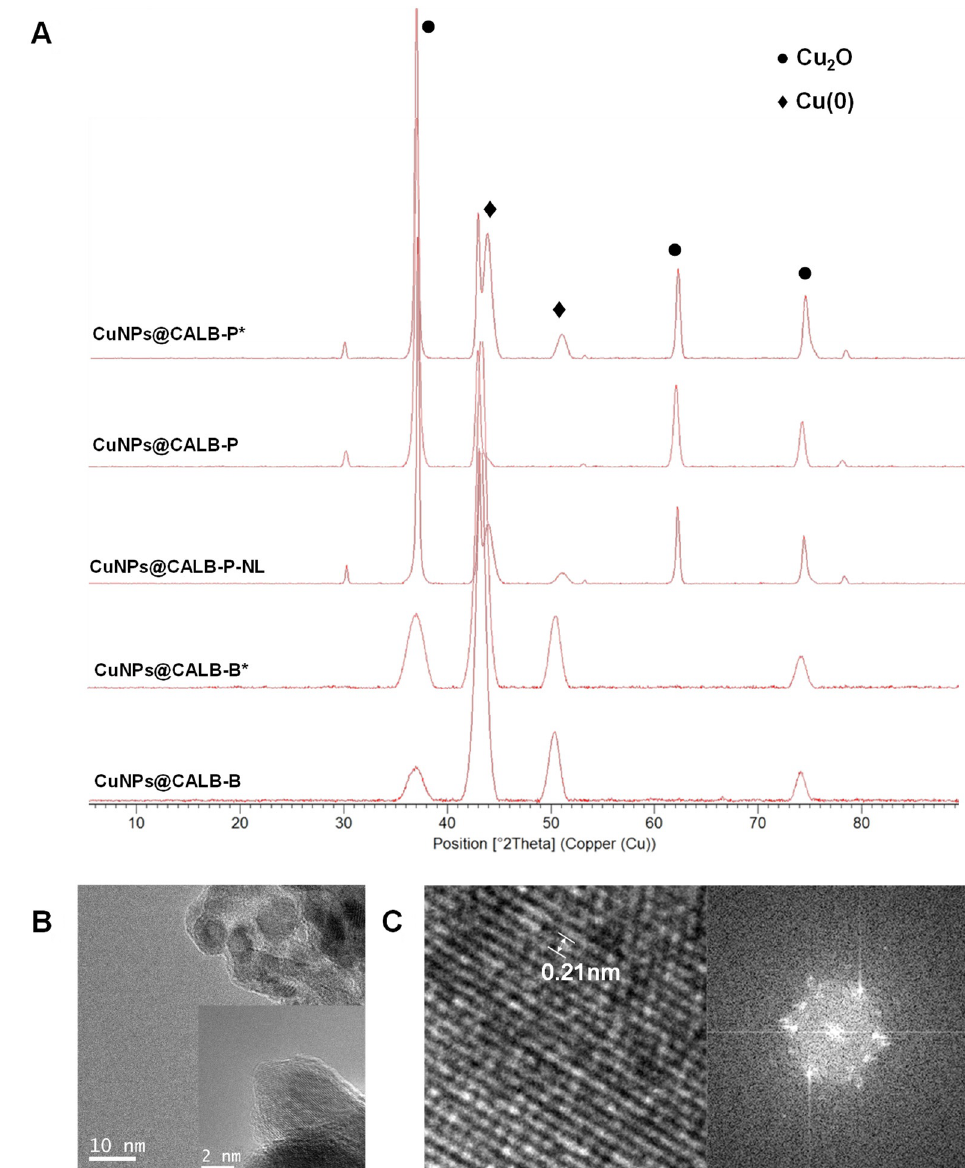
Figure 2. ( A ) XRD spectrum of CuNPs@CALB hybrids; ( B ) TEM and HR-TEM (inset) images of CuNPs@CALB-P ; ( C ) FFT analysis of CuNPs@CALB-P .